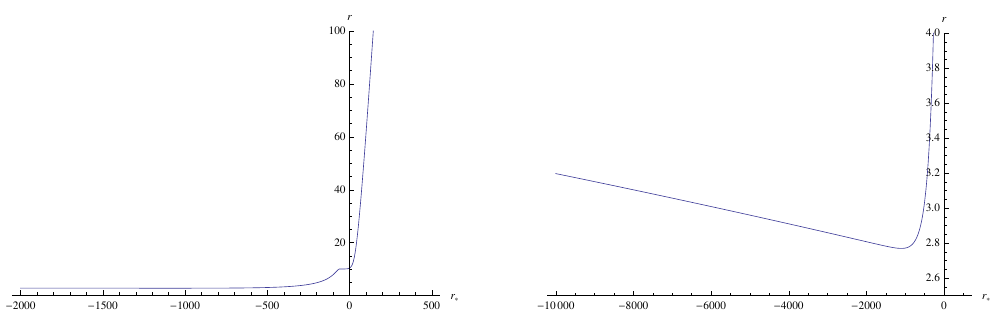
Figure 4 . The radius r for (cid:20)m 0 = 25, r (cid:3) s = (cid:0) 60 < a (cid:3) , a 0 = 10 and (cid:11) = 0 : 05. On the left: the radius r decreases as r (cid:3) decreases for r (cid:3) > a (cid:3) , but starts to increase for r (cid:3) . a (cid:3) . It starts to decrease again from r (cid:3) ’ (cid:0) 60 : 003, which is slightly inside the surface r (cid:3) s . On the right: the radius r starts to increase again with decreasing r (cid:3) for r (cid:3) < (cid:0) 1097.